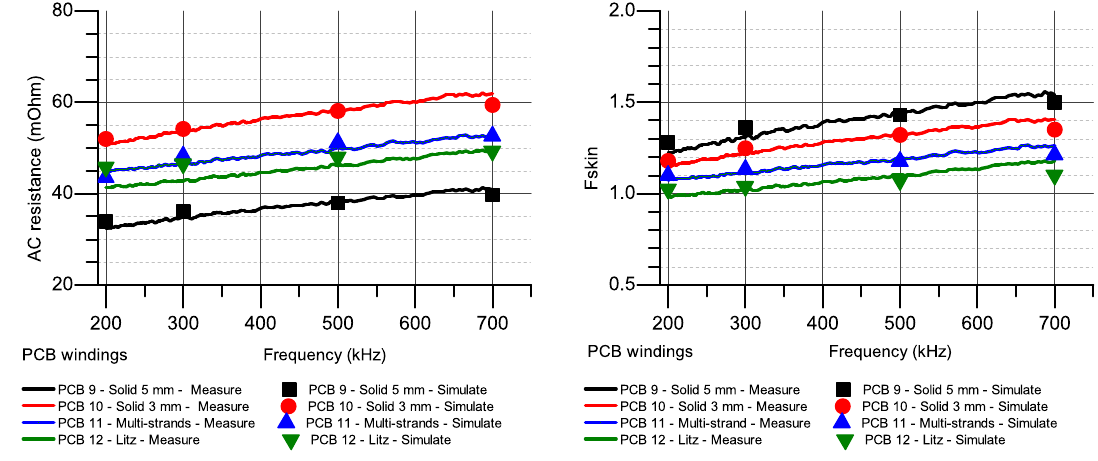
Figure 8. Simulated and measured skin resistances ( Left ) and skin ratio ( Right ) of different